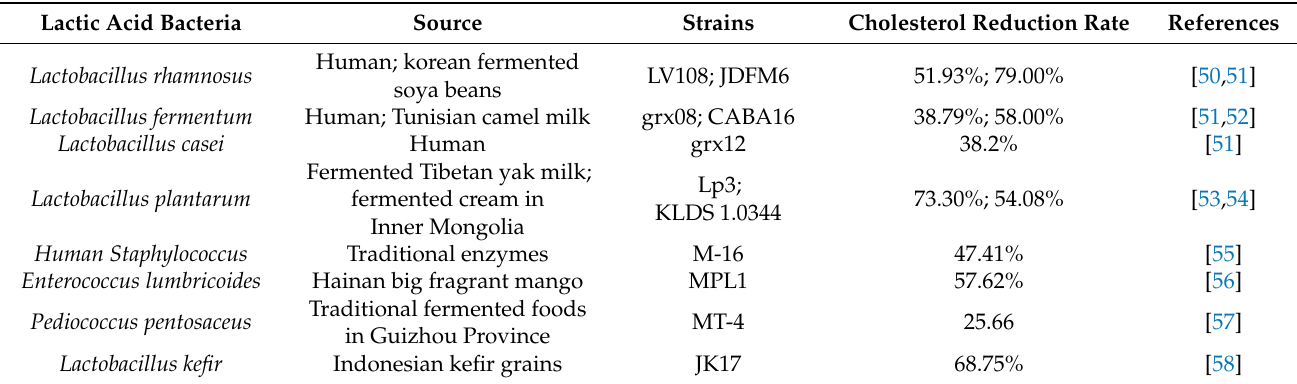
Table 1. Some LAB strains with a cholesterol-lowering